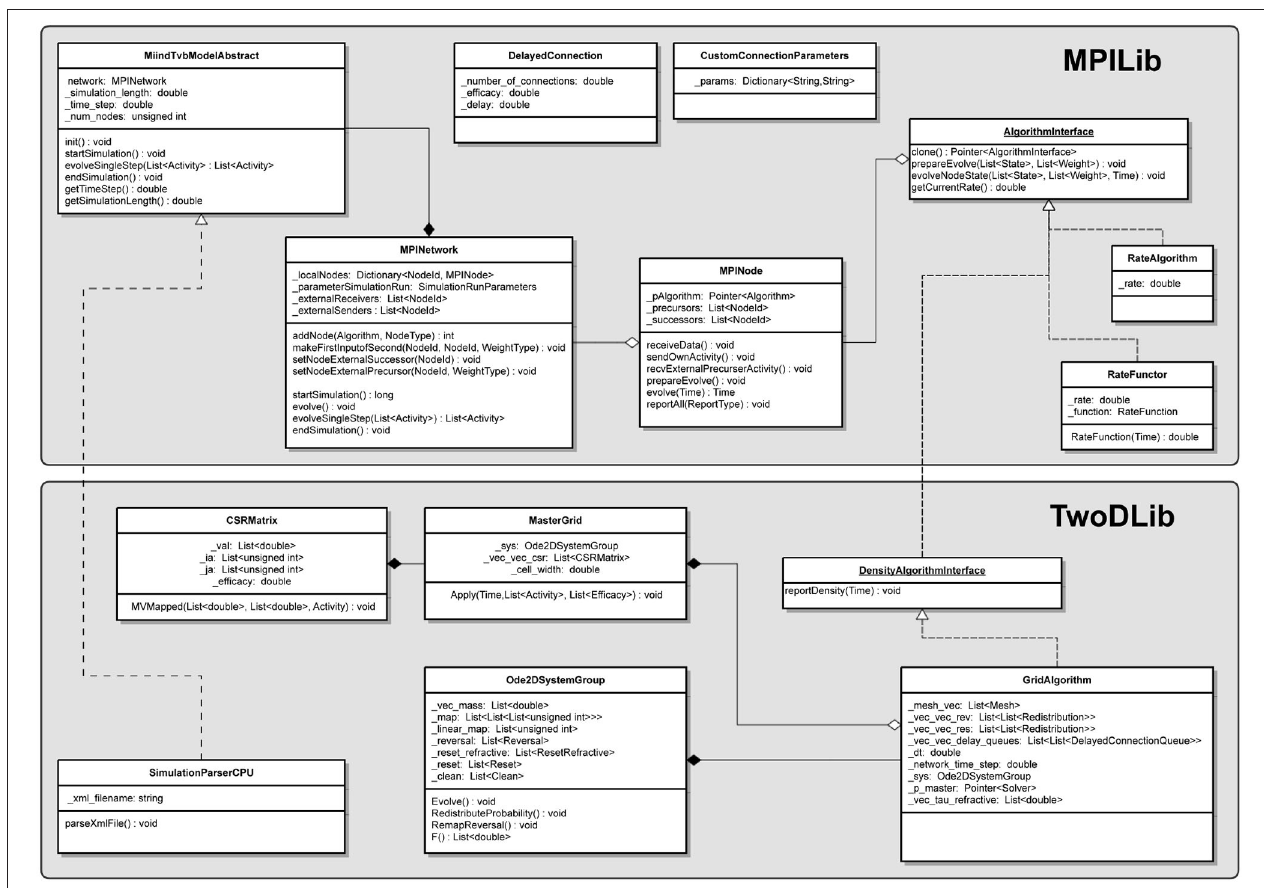
FIGURE 12 | A minimal UML diagram of MIIND. The two major libraries, MPILib and TwoDLib, are represented.